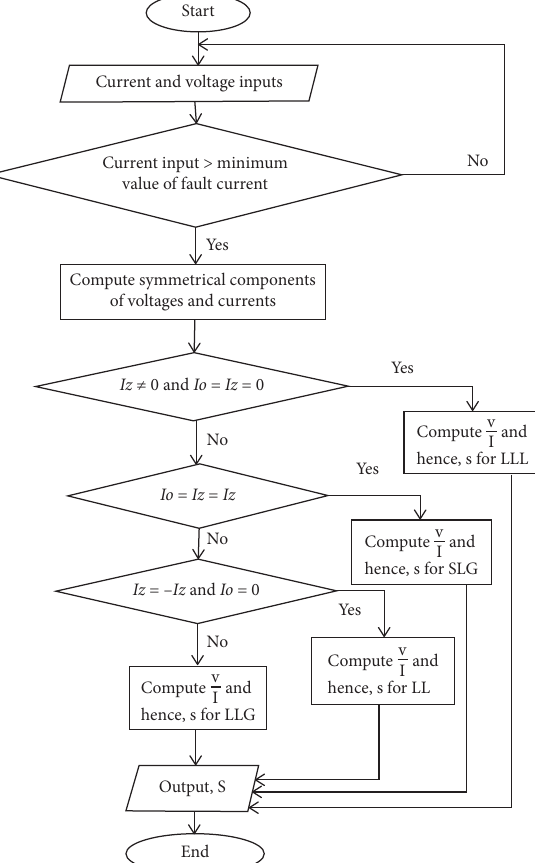
Figure 1: Flow chart for the impedance